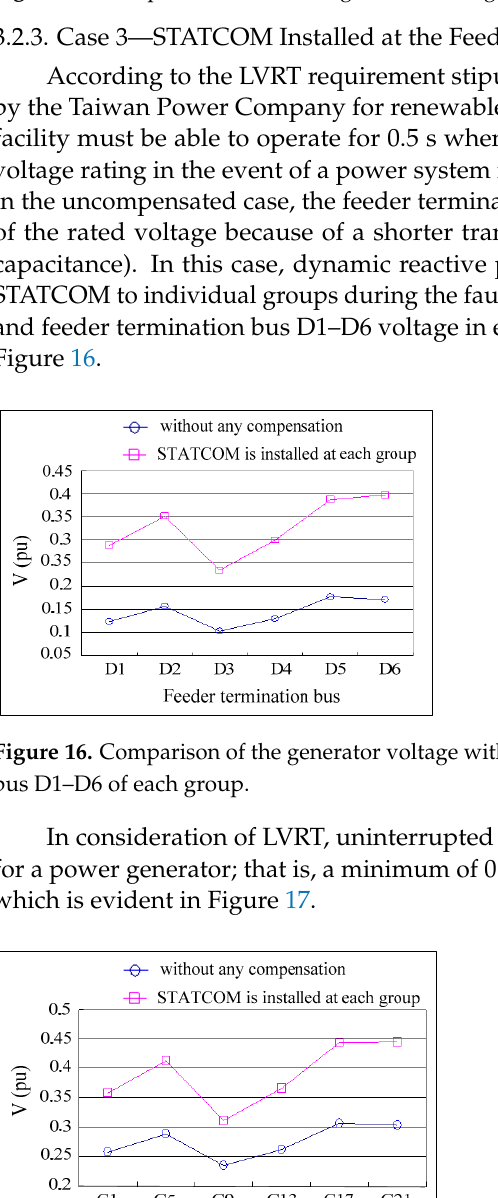
Figure 15. Comparison of the voltages of various generators in the third group.